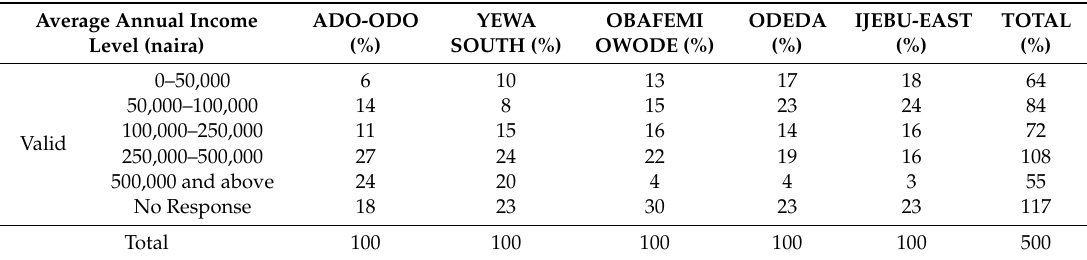
Table 4. Income level.